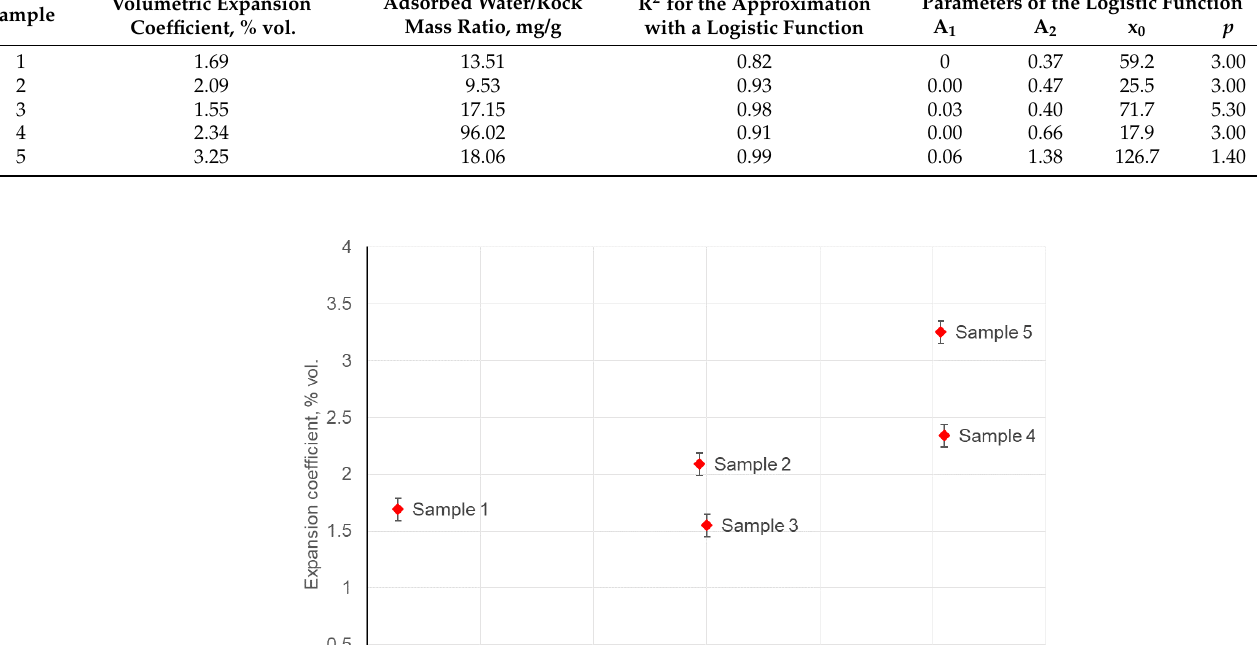
Table 3. Results of the crushed rock swelling experiments in the presence of 0.2% wt. NaOH solution. Sample